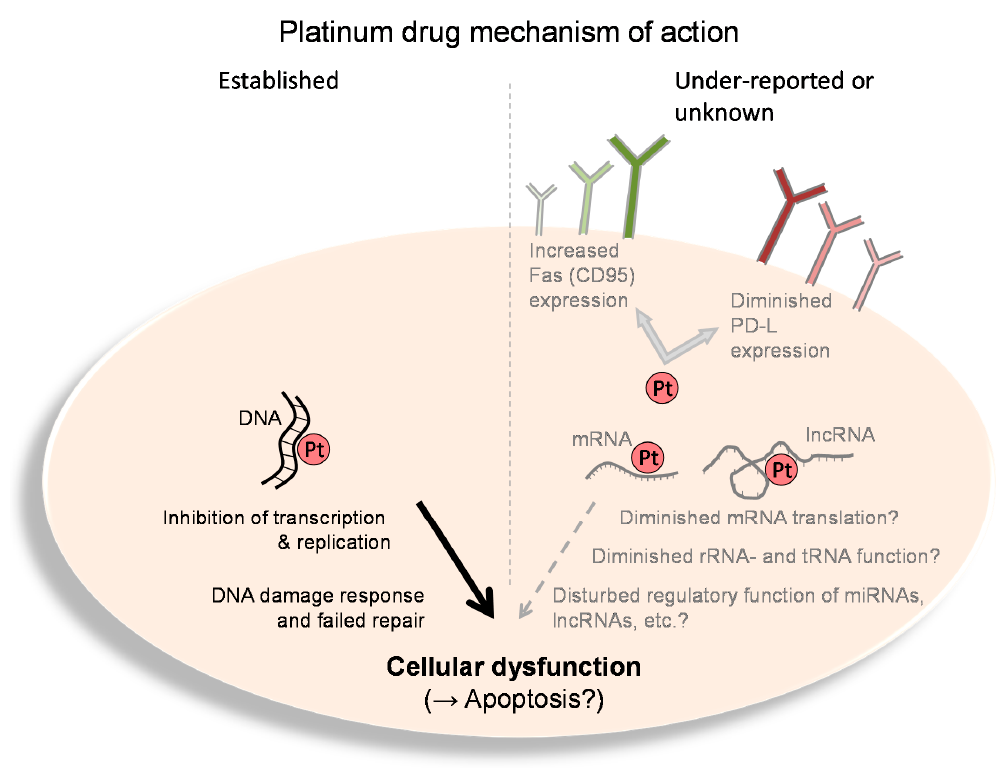
Figure 2. Platinum drug mechanism of action. Left: The established and well-known mechanisms of action of platinum drugs (Pt) comprise platination of genomic and mitochondrial DNA. This leads to hindrance of DNA-based functions (e.g., transcription, replication, etc.). Such cellular dysfunction eventually causes apoptosis, especially when DNA lesions cannot be repaired. Right: The under-reported or currently unknown effects of platinum drugs (Pt) comprise functional inhibition of diverse RNA species such as messenger (m)RNA, ribosomal (r)RNA, transfer (t)RNA, micro(mi)RNA, long non-coding (lnc) RNA, etc. Moreover, platinum drugs such as cisplatin can cause upregulation of Fas (CD95) or downregulation of programmed death ligand (PF-L) expression, eventually leading to enhanced immunosurveillance or T cell–mediated cell lysis, respectively. Platinum-mediated adducts were also detected in messenger (m)RNA [17]. Using a cell-free approach (not biased by cellular background) interaction of cisplatin with mRNA has recently been demonstrated to hinder mRNA translation. Exposing GFP-encoding mRNA to platinum drugs for